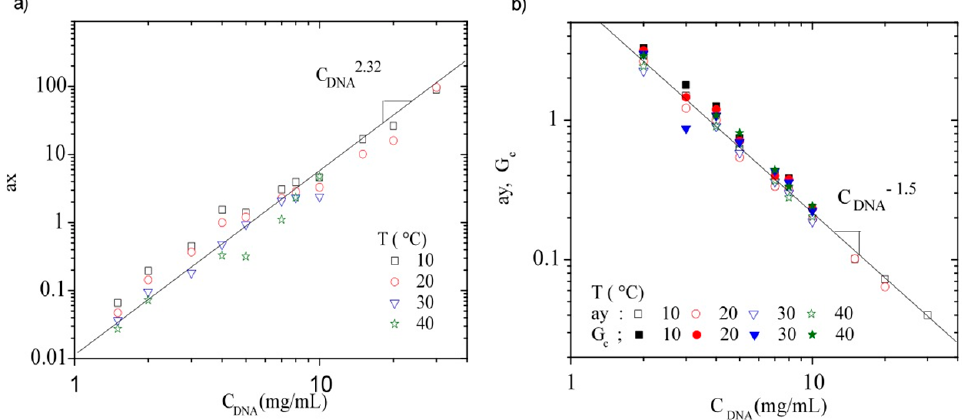
Figure 16. ( a ) Frequency translation coefficient (ax) as a function of DNA concentration and ( b ) G modulus translation coefficient (ay) and G c as a function of DNA concentration, at all studied temperatures.